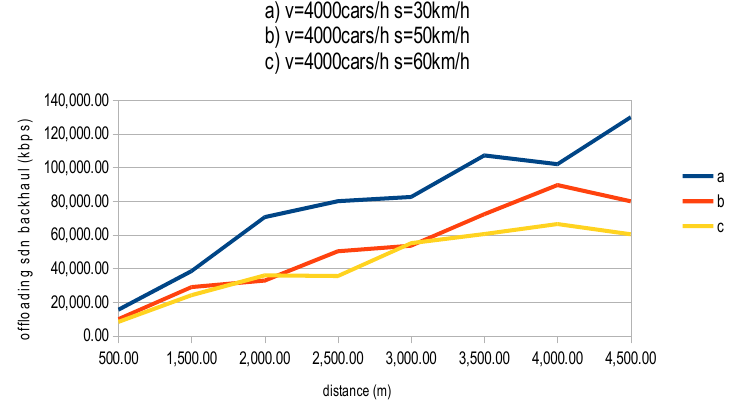
Figure 9. The rate of data offloaded to the backhaul network for scenario (C).